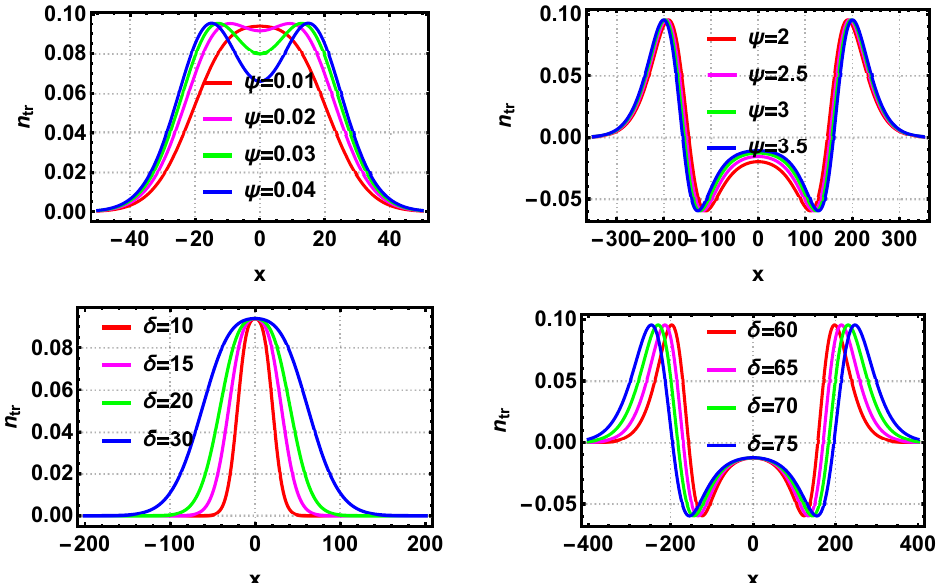
Figure 6. The characteristics of trapped ion density for different ψ and δ are shown. The top panels show the case for different ψ keeping the T r = 3 and δ constant. In the top left panel, the values of ψ are taken from Region 1, and δ is assumed to be 10. In the top-right panel, the values of ψ are taken from Region 2, and δ is assumed to be 60. The bottom panels show the case for different δ keeping the T r = 3 and ψ constant. In the bottom left panel, ψ is assumed to be 0.01 (from Region 1), whereas in the bottom right panel ψ is assumed to be 2 (from Region 2) for different values of δ